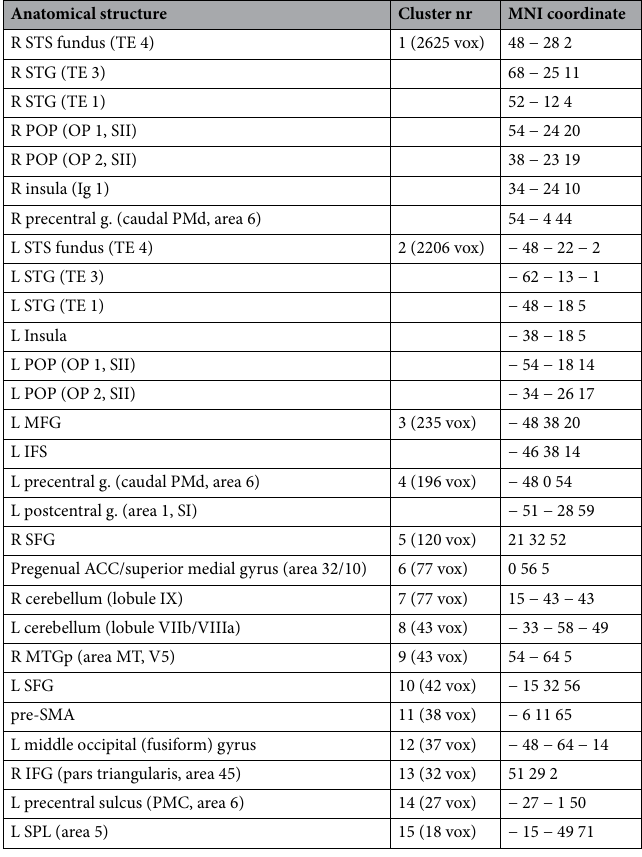
Table 1. List of clusters of voxels (and local maxima within clusters) carrying significant information about the difference between joy- and fear-music. ACC anterior cingulate cortex; CS central sulcus; FOP frontal operculum; HG Heschl’s gyrus; IFG inferior frontal gyrus; IFS inferior frontal sulcus; Ig granular subregion of the insular cortex; L left; MFG middle frontal gyrus; MTGp posterior middle temporal gyrus; OP subregion of the parietal operculum; PMC premotor cortex; PMd dorsal premotor cortex; PoCG postcentral gyrus; POP parietal operculum; pre-SMA pre-supplementary motor area; R right; SFG superior frontal gyrus; SII secondary somatosensory cortex; SPL superior parietal lobule; STG superior temporal gyrus; STS superior temporal sulcus; TE temporal (auditory)